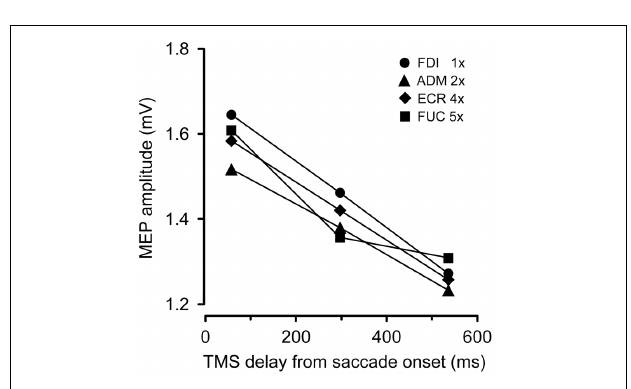
FIGURE 2 | Average EMG recordings from relaxed FDI, ADM, ECR, and FCU muscles in a representative subject. All muscles show a progressive decay of MEP amplitude as a function of the TMS delay (D1, D2, and D3) from saccade onset. The amplitude calibration mark represents 1.0, 0.2, 0.35, and 0.2mV for the FDI, ADM, ECR, and FCU muscles, respectively.